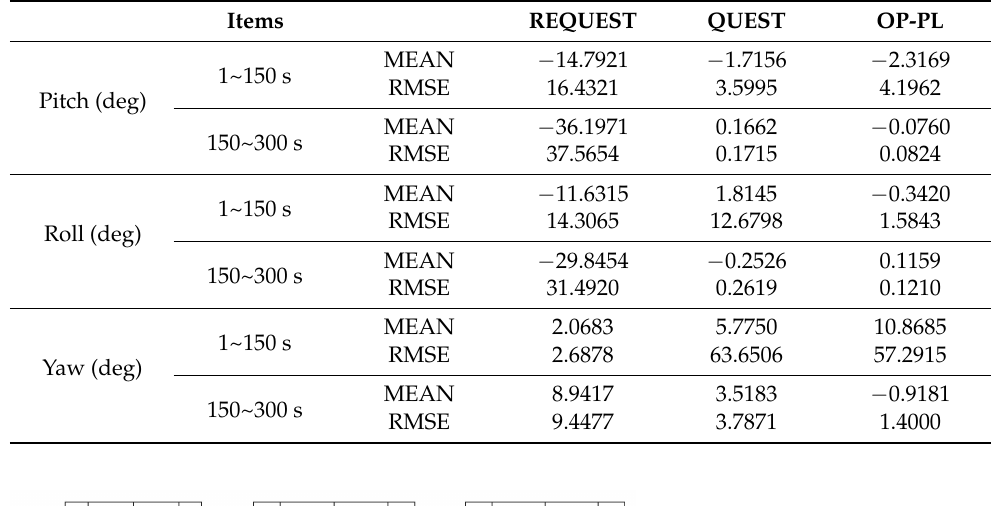
Table 3. Error statistics of three algorithms in simulation test.